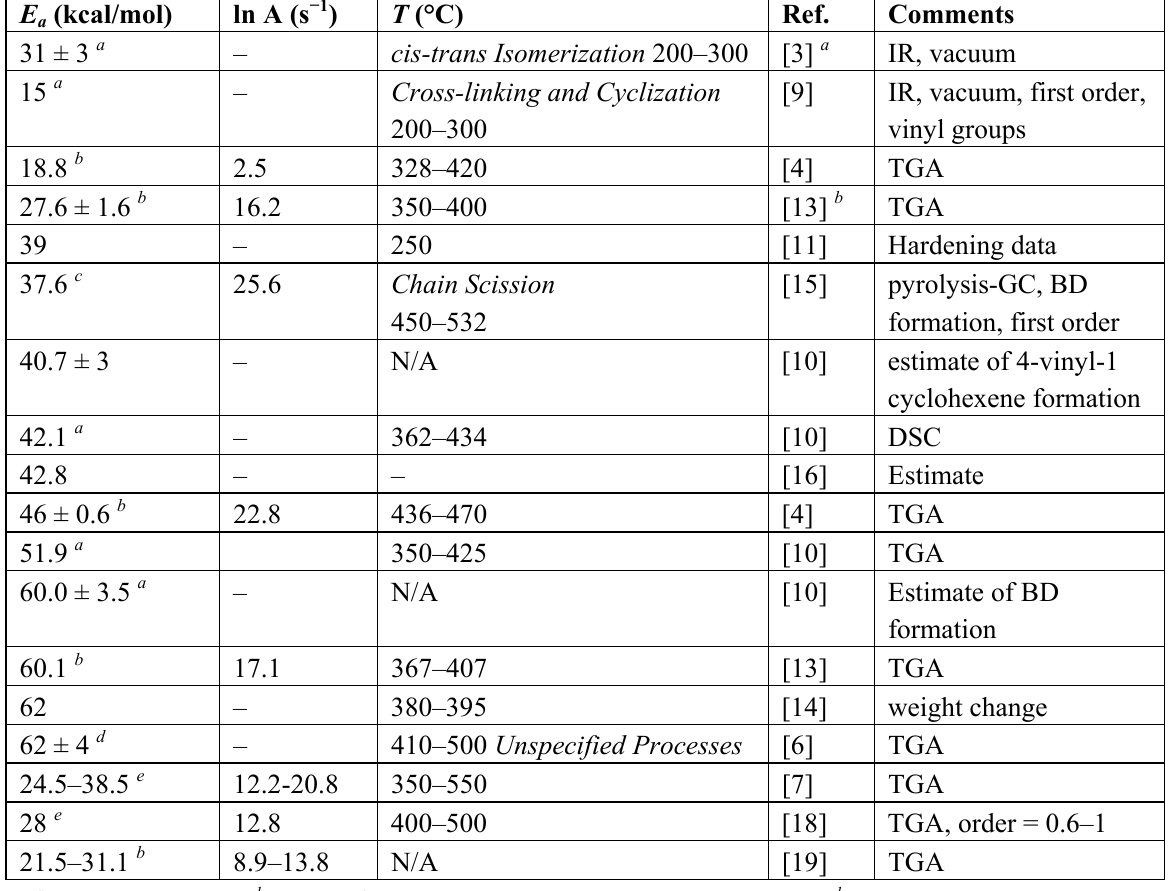
Table 7. Arrhenius Data for Polybutadiene Polymers at Heating Rates ≤ 100